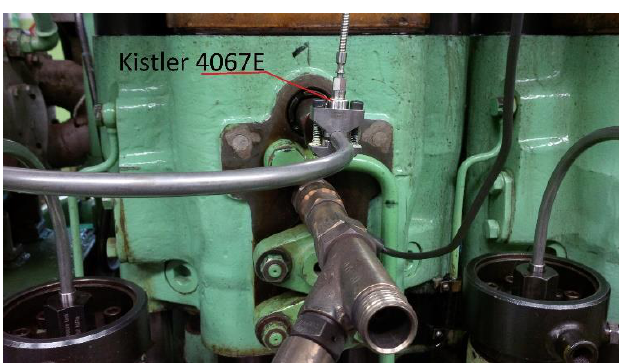
Figure 1. Installation of the Kistler 4067E injection pressure sensor (in the background, the electric cable of the Kistler 6353A24 combustion pressure sensor protruding from the indicator cock).